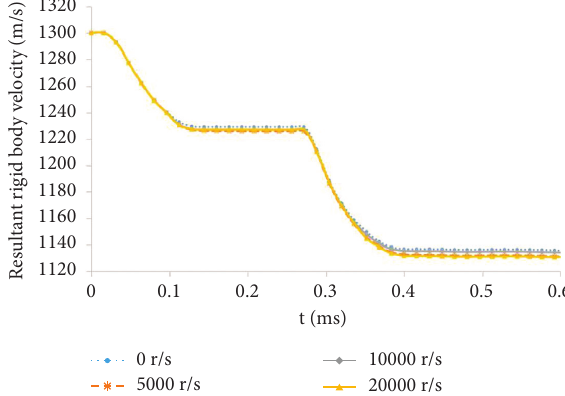
Figure 9: Intrusive speed graph when the speed changes.